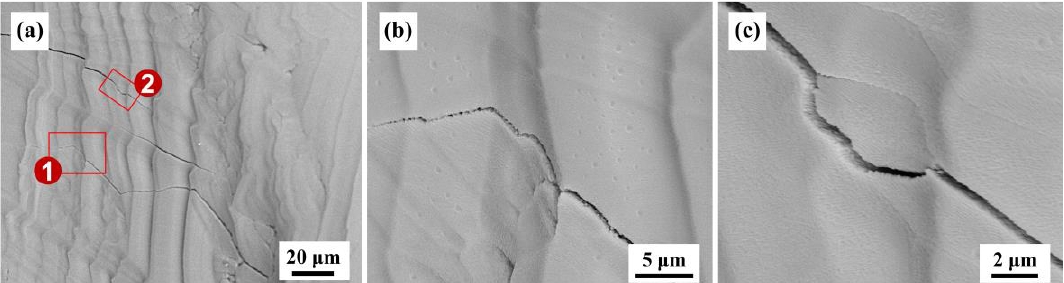
Figure 5. Thermal-stress-induced crack deflection at raised striations of wrinkle-textured, nanostructured Al 2 O 3 -ZrO 2 eutectic ceramics formed by the oxyacetylene flame remelting (OAFR) process; ①② are the visible cracks and the regions of ① and ② marked by red rectangles in ( a ) are correspondingly shown in ( b , c ) [65], Copyright © 2018 The American Ceramic